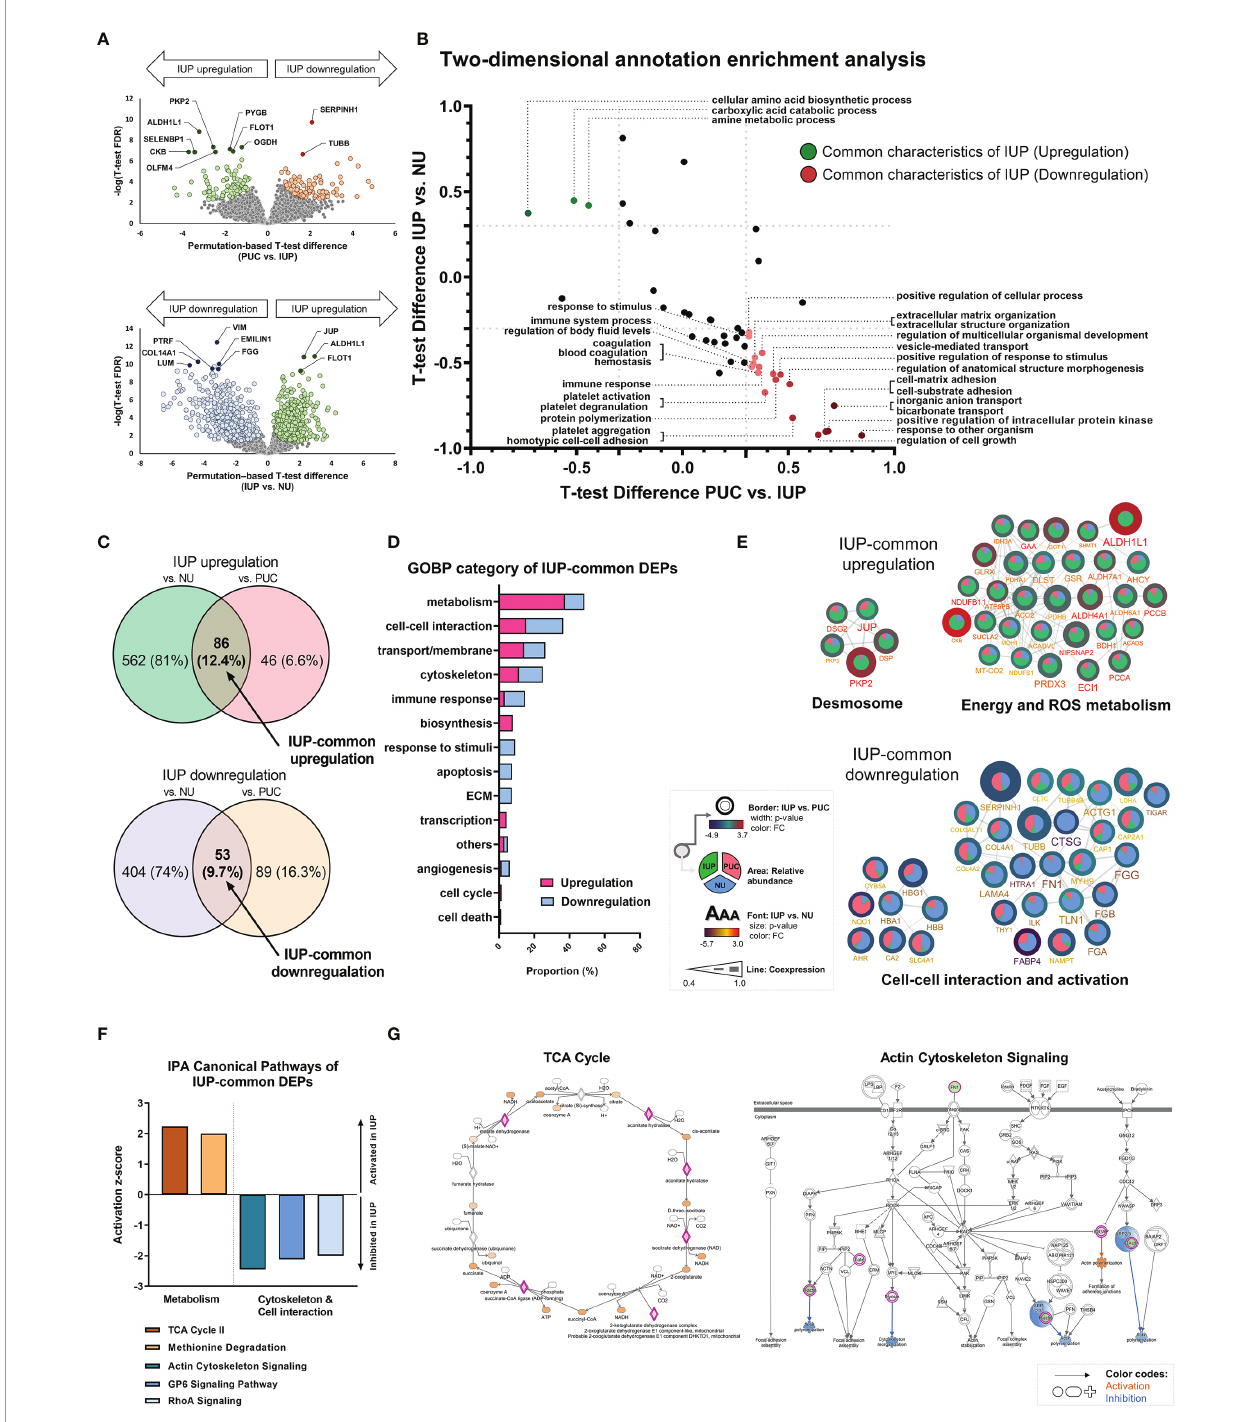
FIGURE 2 | Unique functional pro fi les of inverted urothelial papilloma (IUP). (A) Differentially expressed proteins (DEPs) identi fi ed by using t-tests between IUP and papillary urothelial carcinoma (PUC) (upper) and between IUP and normal urothelium (NU) (lower). (B) Matched Gene Ontology-Biologic Processes (GOBPs) commonly enriched in the DEPs from both comparisons (PUC vs. IUP and IUP vs. NU). (C) DEPs commonly upregulated or downregulated in IUP compared with NU and PUC (IUP-common DEPs). (D) GOBP categories related to the IUP-common DEPs. (E) Protein – protein interaction networks of the upregulated and downregulated IUP-common DEPs and their related functions. Unconnected proteins are not presented. (F) Ingenuity Pathway Analysis (IPA)-canonical pathways predicted to be activated (metabolism) or inhibited (cytoskeleton and cell – cell interaction) in IUP. (G) Detailed IPA pathways (TCA and actin-cytoskeleton signaling) showing activated (orange) or inhibited (blue) components in